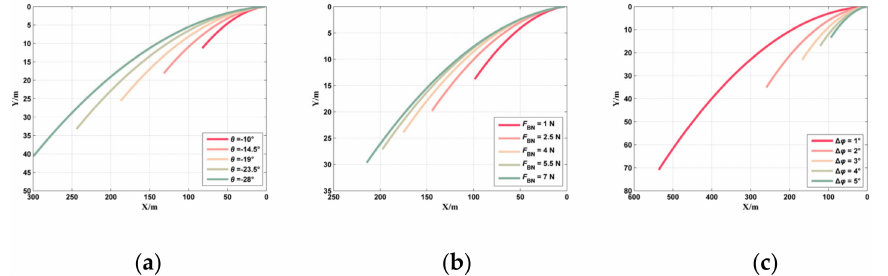
Figure 6. Two-dimensional trajectory of Petrel-L under different pitch angles ( a ), net buoyancies ( b ), and rotation angle errors ( c